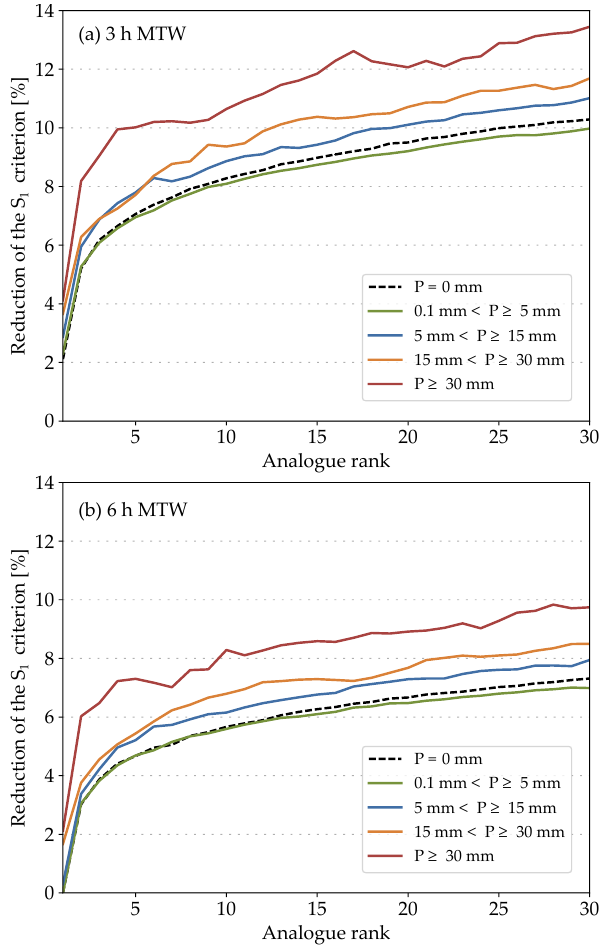
Figure 4. Synthesis of the changes in the S 1 criterion due to the MTW with 12, 6, and 3h time steps for the Ulrichen station depend- ing on the rank of the analogue. (a) Quantiles of the S 1 distributions corresponding to the MTW with different time steps; 24h is the conventional approach without MTW. (b) Quantiles of the relative improvements of the S 1 criterion when using the MTW compared with the conventional approach.